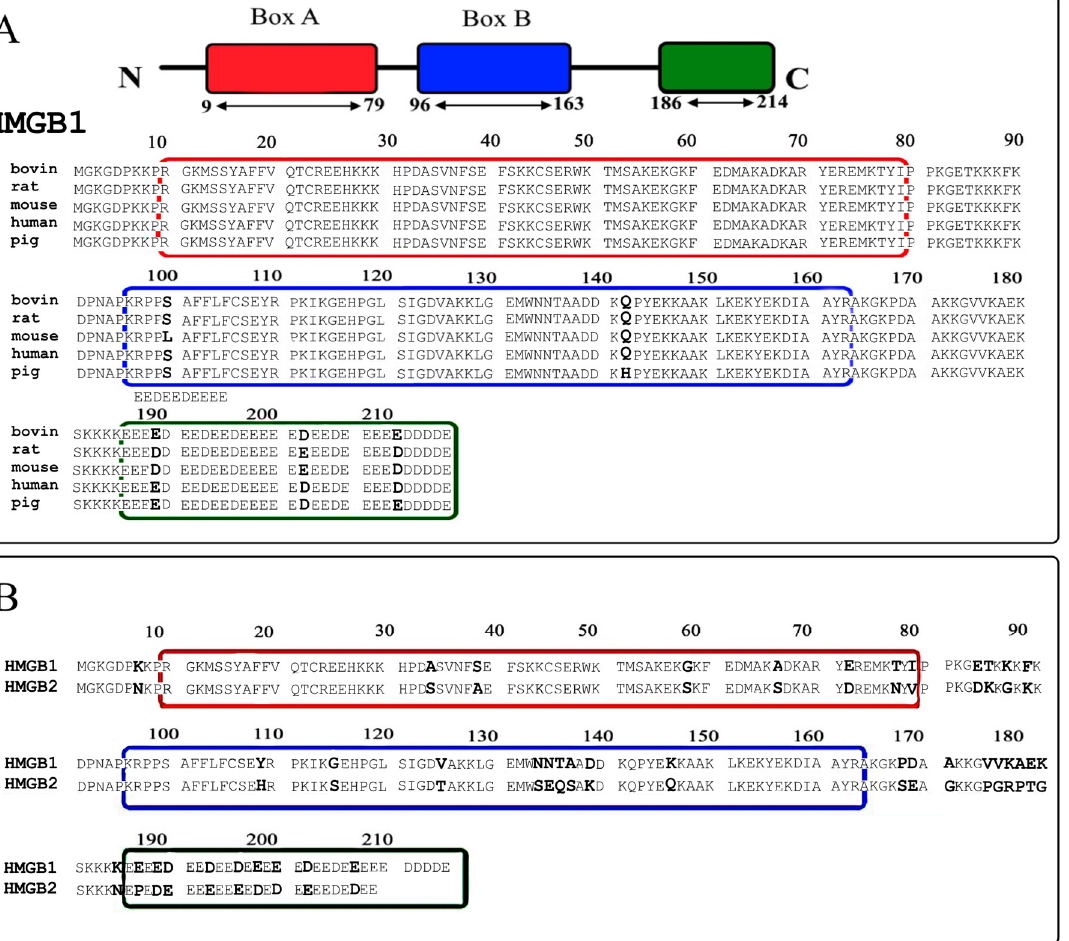
Figure 1. Primary structures of HMGB1 and HMGB2 proteins. Panel A : primary structures of the bovine, rat, mouse, human, and pig HMGB1 proteins. Panel B : primary structures of bovine HMGB1 and HGB2. The DNA-binding A- and B-domains are marked with red and blue boxes, respectively. Green box corresponds to the C-terminal acidic region. Amino acid substitutions, identified for different species, are marked with bold letters.